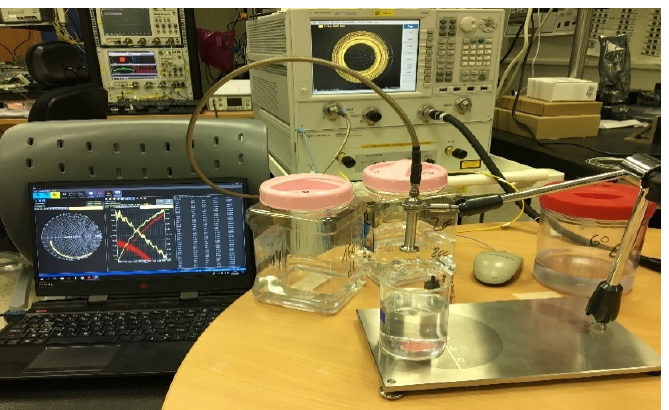
Figure 12. Solutions being tested for their material characterization via SPEAG DAK tool.